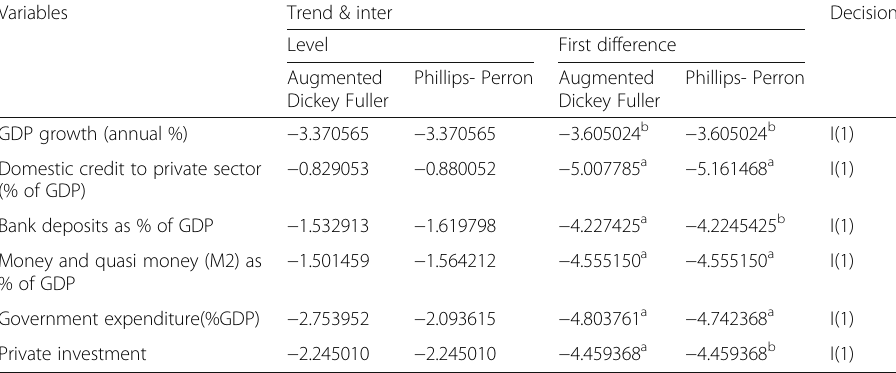
Table 3 Unit root test Variables